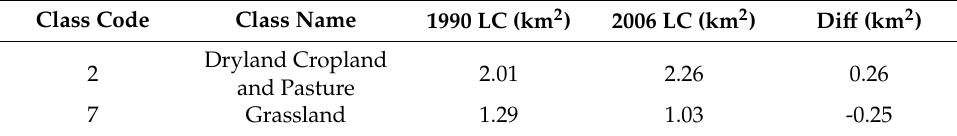
Table 6. LCLU changes between 1990 and 2006 in the third selected sub-basin (Sub-Basin 11). Class Code